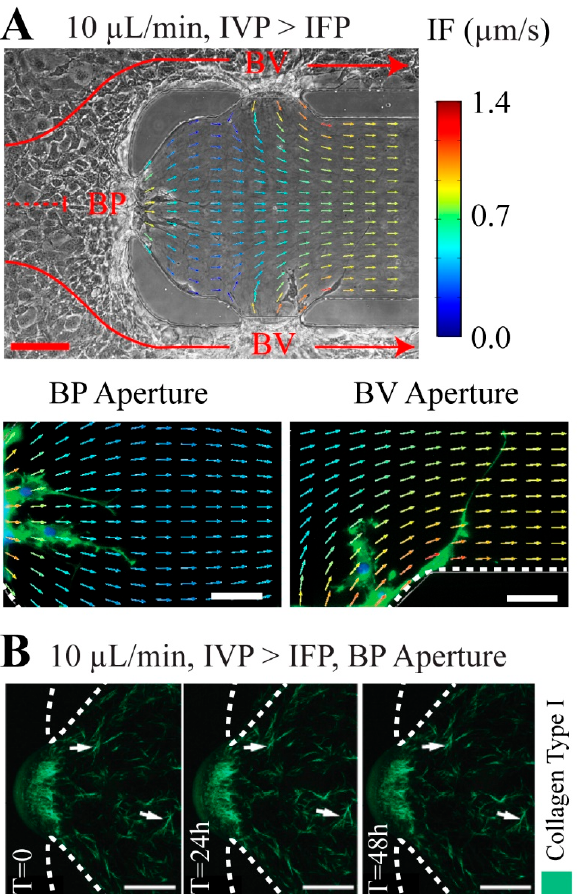
alignment with the interstitial flow streamlines. ( A ) The computational interstitial flow streamline map superimposed on representative phase contrast and epifluorescence images of the angiogenic sprouts formed under elevated IVP condition. ( B ) Confocal reflectance microscopy images of collagen fibers under application of interstitial flow in the absence of MAECs. Arrowheads in the panels indicate landmark fibers to track among these images. Interstitial flow did not elicit a direct change in collagen fiber orientation. Red scale bar, 100 µ m. White scale bars, 50 µ m. Dashed white lines mark the location of the PDMS